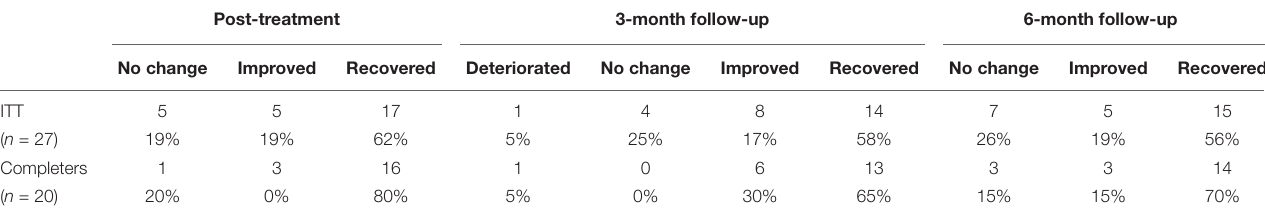
TABLE 4 | Clinical significance outcomes on